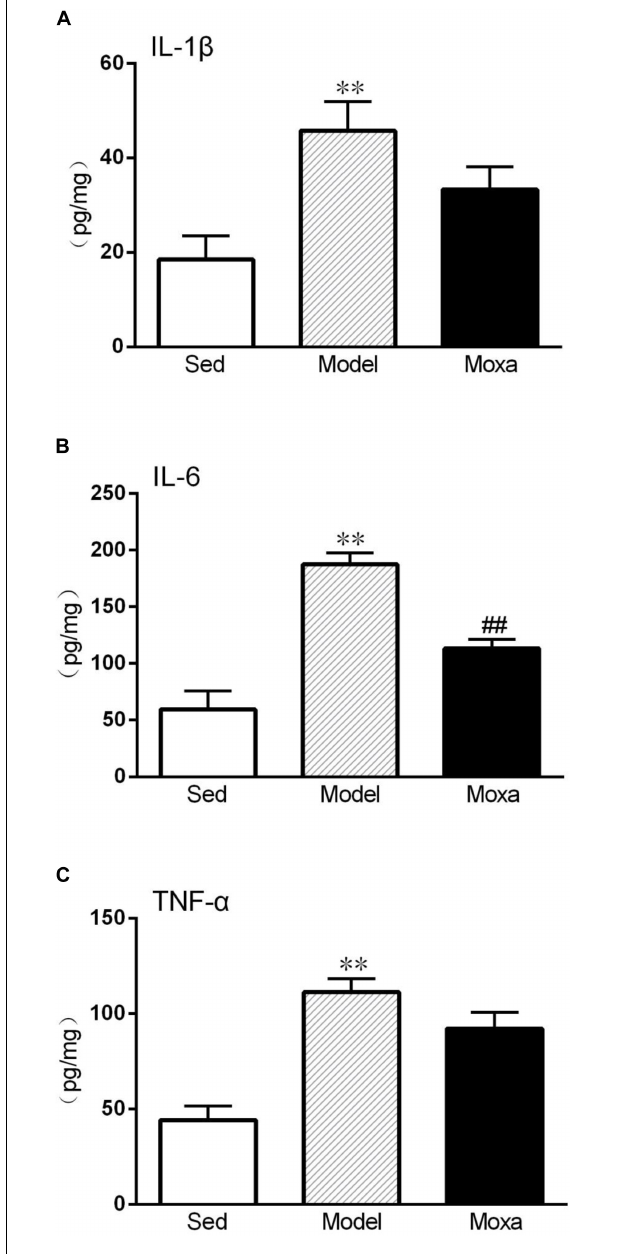
FIGURE 6 | Hippocampus cytokines levels measured by ELISA in the following groups ( N = 8 per group): Sedentary (Sed), Model, Moxibustion (Moxa). (A) Hippocampus level of IL-1 β . (B) Hippocampus level of IL-6. (C) Hippocampus level of TNF- α . Data are means ± SEM. ∗∗ P < 0.01 as compared with the Sed group, ## P < 0.01, as compared with the Model